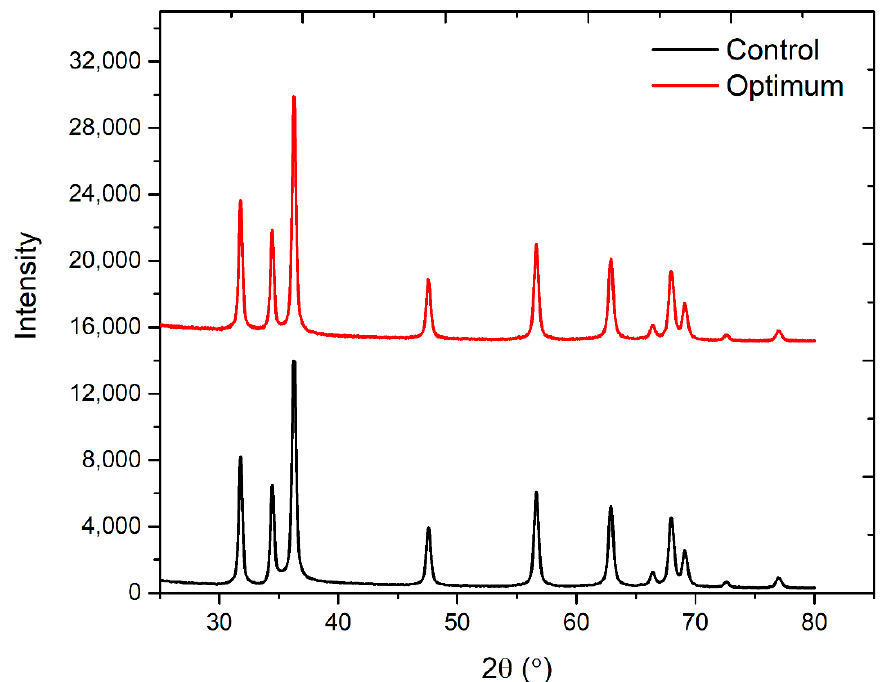
Figure 6. XRD patterns of control and optimum cotton samples after five coating cycles. Table 3. XRD parameters of ZnO after five coating cycles.